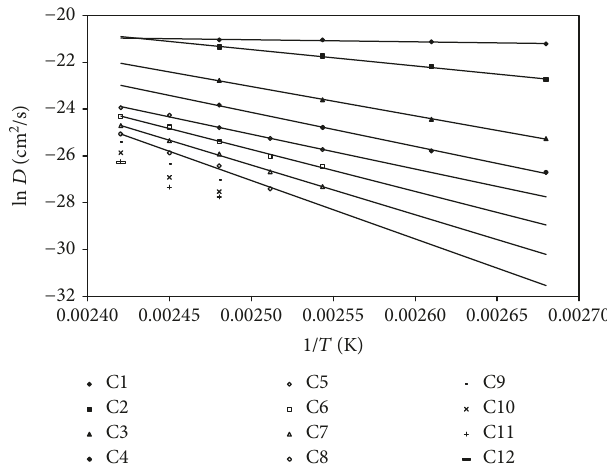
Figure 4: Correlation between the reciprocal temperature and the logarithm of the di ff usion coe ffi cient D investigated n -alkanes.